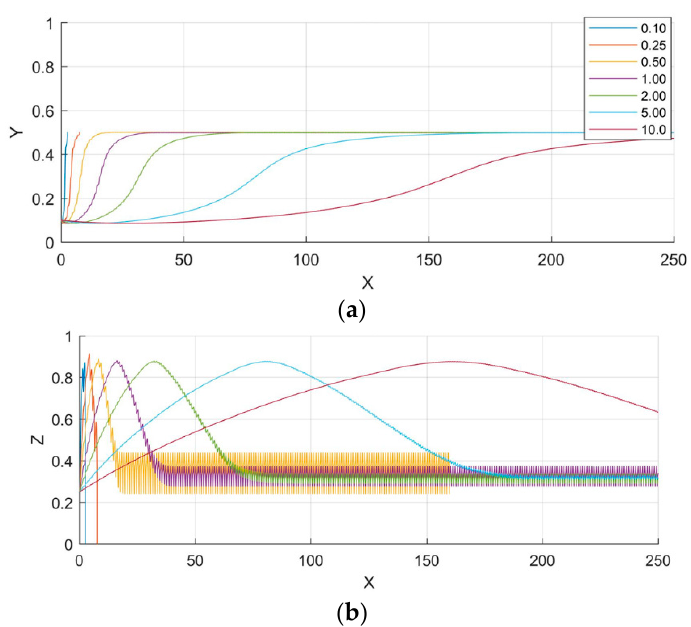
Figure 6. The impact of Reynolds number on the trajectory of microparticles ( a ) top view; and ( b ) side view. The Reynolds numbers are given in the legend of ( a ). The projections on the planes xy and xz are shown. X, Y, and Z are the dimensionless lengths x/L, y/L, and z/Hch, respectively. The influence of the radius of the perforated surface is studied and the results are shown in Figure 7. The figure represents non-dimensional displacements. It can be noticed from Figure 7 that at Re = 0.1 the microparticle cannot be focused and drop to the bottom of the microchannel. This happens because the drag force experienced by the microparticle is smaller than the horizontal component of the nDEP force opposing it. On the other hand, for higher Re the steady-state levitation height increases with increase in the radius of the mesh pattern. It can also be noticed that with reduction in the radius of the mesh-pattern, without altering the Re , the axial distance required for the microparticle to reach the steady state location increases. When the radius of the perforated surface is reduced, the width of the microchannel reduces thereby leading to increased velocity of fluid and axial displacement.